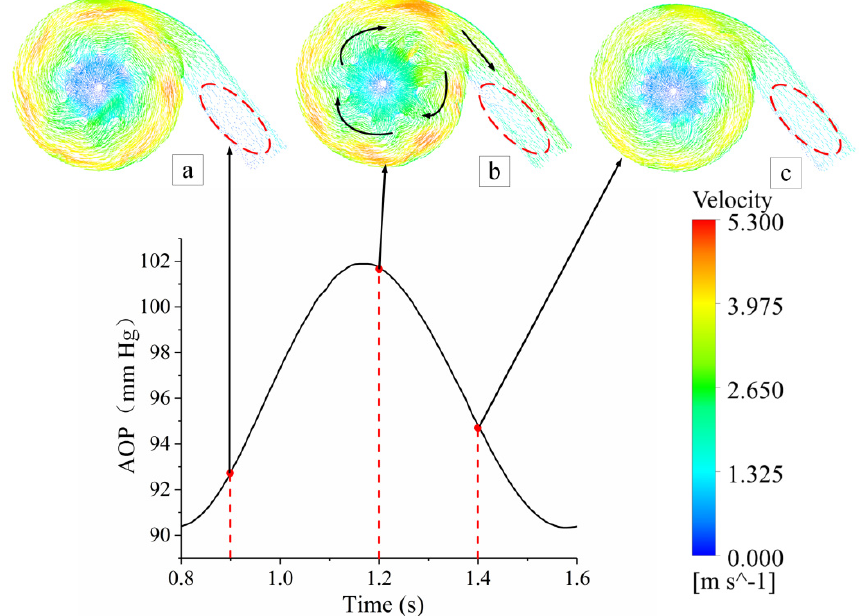
Figure 15. Flow-field variation characteristics of the blood pump at different moments in the pulsating speed pattern. The panels (a) to (c) show the velocity vector of the flow field inside the blood pump when the aortic pressure increased ( a ) at 0.9 s, ( b ) was at peak at almost 1.2 s, and ( c ) decreased at 1.4 s. Black arrows indicate the direction of fluid flow.